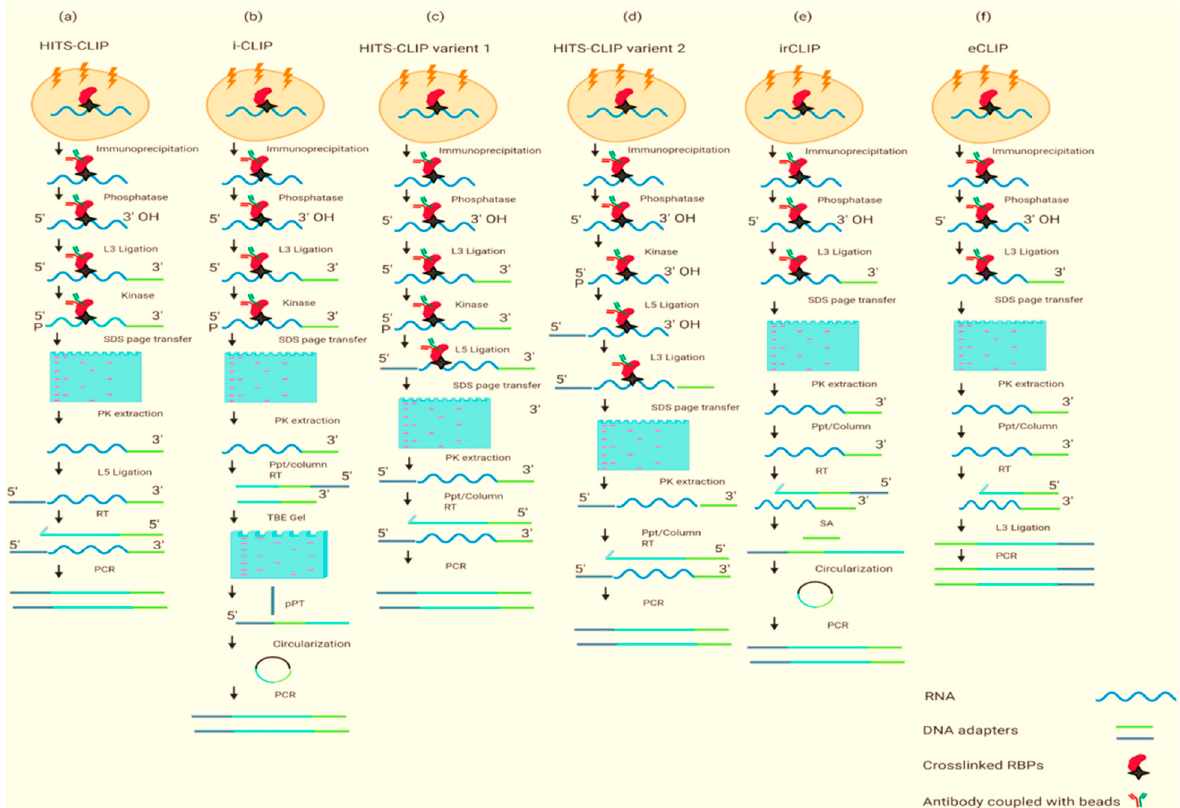
Figure 1. The above chart was modified from [11] in which ( a – f ) shows the graphical representation of CLIP-seq methods. Although all CLIP methods are not included, a detailed explanation is given in Table 1. XL, UV cross-linking; IP, immunopurification; phosphatase, removal of 3 ′ phosphate; kinase, the addition of 5 ′ phosphate; RT, reverse transcription; L3, 3 ′ adaptor ligation to RNA or DNA; L5, 5 ′ adaptor ligation; PK extraction, proteinase K extraction from nitrocellulose membrane; Ppt/column, alcohol precipitation or column cleanup of nucleic acid; TBE, Tris–borate–EDTA; SA, streptavidin.